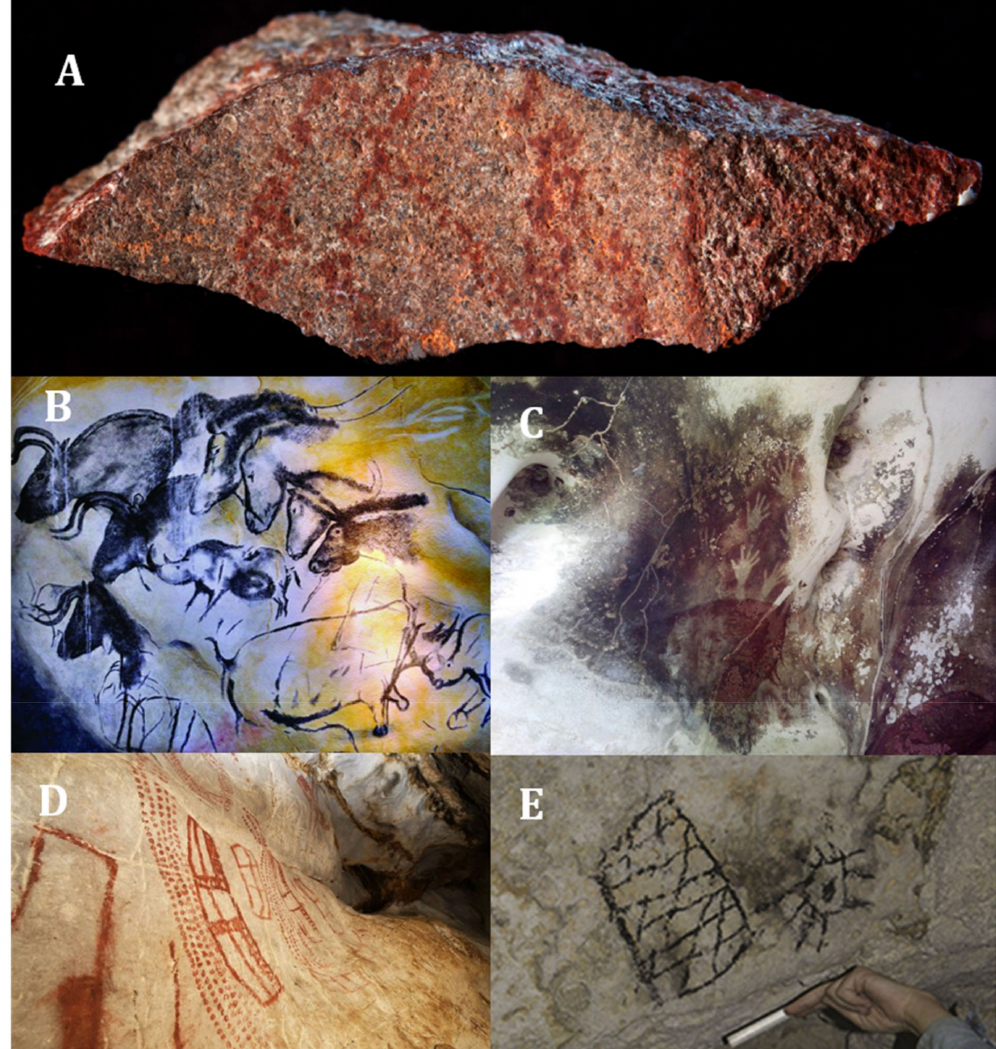
Figure 1. Pigments used in some caves with cave paintings made during the Middle Stone Age. ( A ) Ochre pigment in Bombs Cave, Southern Cape Town, South Africa (https://www.nationalgeographic.com/science/article/news-ancient-humans- art-hashtag-ochre-south-africa-archaeology Accessed on: 28 May 2021) [59]. ( B ) Coal pigment in Chauvet Cave, France (https://www.newyorker.com/magazine/2008/06/23/first-impressions Accessed on: 28 May 2021) [58]. ( C ) Pettakere Cave, Maros, Indonesia (https://reydekish.com/2015/09/21/cuevas-de-indonesia/ Accessed on: 28 May 2021). ( D ) Ochre pigment in El Castillo cave, Spain (https://www.efetur.com/noticia/expresiones-ser-human/ Accessed on: 28 May 2021), (https://www.donsmaps.com/castillo.html Accessed on: 28 May 2021). ( E ) Coal pigment in the Mona Island Cave, Puerto Rico